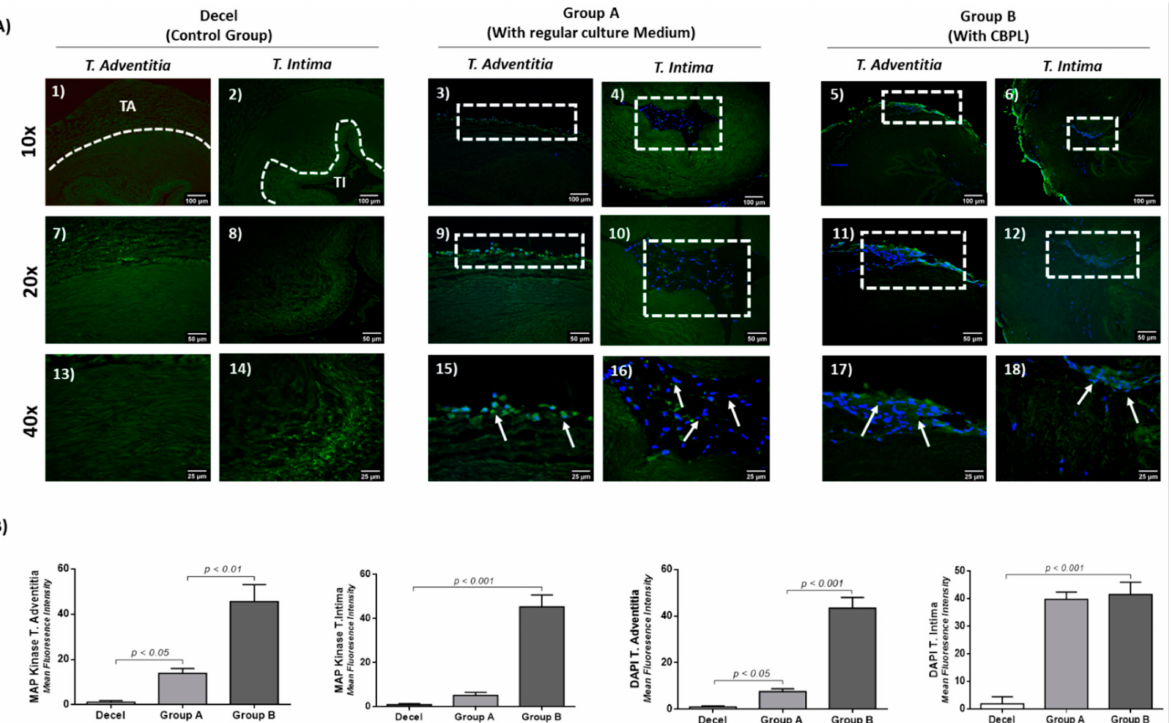
Figure 10. Indirect immunofluorescence against MAP kinase in combination with DAPI stain in repopulated hUAs ( A ). Decellularized hUAs did not exhibit any expression of anti-MAP kinase or DAPI stain ( 1 , 2 , 7 , 8 , 13 , 14 ) either in tunica adventitia or tunica intima regions. Repopulated hUAs in group A (cultured with regular medium) were characterized by both anti-MAP expression and DAPI stain ( 3 , 9 , 15 , 4 , 10 , 16 ). However, both signals were restricted only to the tunica adventitia of the repopulated hUAs ( 3 , 9 , 15 ). Repopulated hUAs in group B (with the use of CBPL) positively expressed the MAP kinase and DAPI stain both in tunica adventitia and tunica intima regions ( 5 , 11 , 17 , 6 , 12 , 18 ). Images ( 1 – 6 ) presented with original magnification 10 × , scale bars 100 µ m. Images ( 7 – 12 ) presented with original magnification 20 × , and scale bars 50 µ m. Images ( 13 – 18 ) presented with original magnification 40 × , and scale bars 25 µ m. Mean Fluorescence Intensity of MAP kinase and DAPI stain ( B ). Statistically significant differences regarding the MAP kinase expression and DAPI stain both in tunica adventitia ( p < 0.01) and tunica intima ( p < 0.001) in all groups. TA: Tunica Adventitia, TI: Tunica Intima. White boxes and arrows presented the presence of cells in repopulated